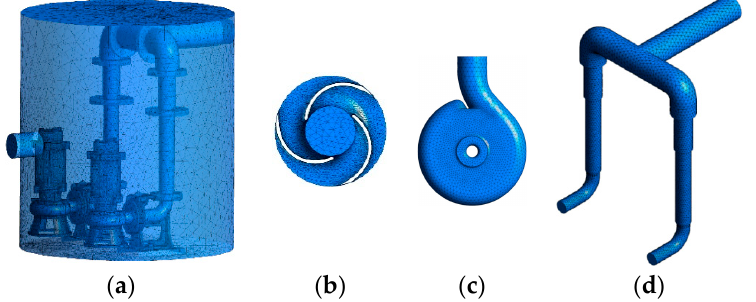
Figure 2. Grid of each calculation domain. ( a ) Prefabricated barrel grid; ( b ) impeller grid; ( c ) worm gear grid; ( d ) outlet section grid.